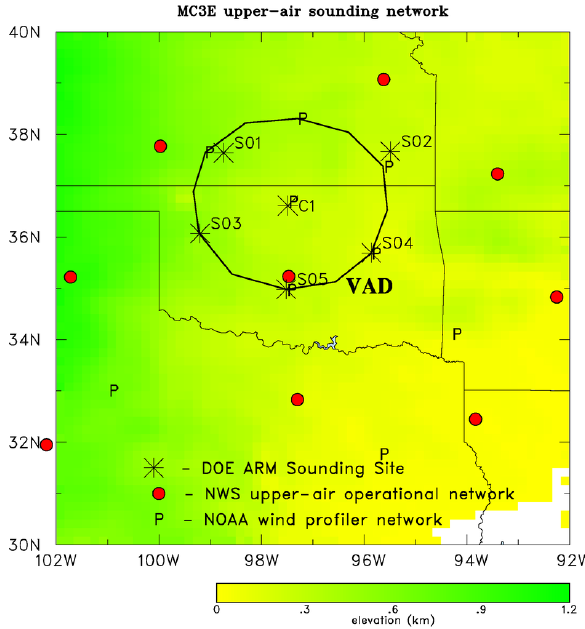
Figure 1. Map of the MC3E ground-based observing domain in- cluding the outer sounding domain: Central Facility [C1 Lamont, Oklahoma (OK) 36.695 ◦ latitude, − 97.485 ◦ longitude] S1 Pratt, Kansas (KS) [37.7, − 98.75]; S2 Chanute, KS [37.674, − 95.488], S3 Vici, OK [36.071, − 99.204]; S4 Morris, OK [35.687, − 95.856]; S5 Purcell, OK [34.985, − 97.522]. Also shown on this map are surrounding sites from the NWS operational sonde network and NOAA profiler network. Variational analysis domain (VAD) is indi- cated with a polygon. Shading indicates elevation according to the scale at